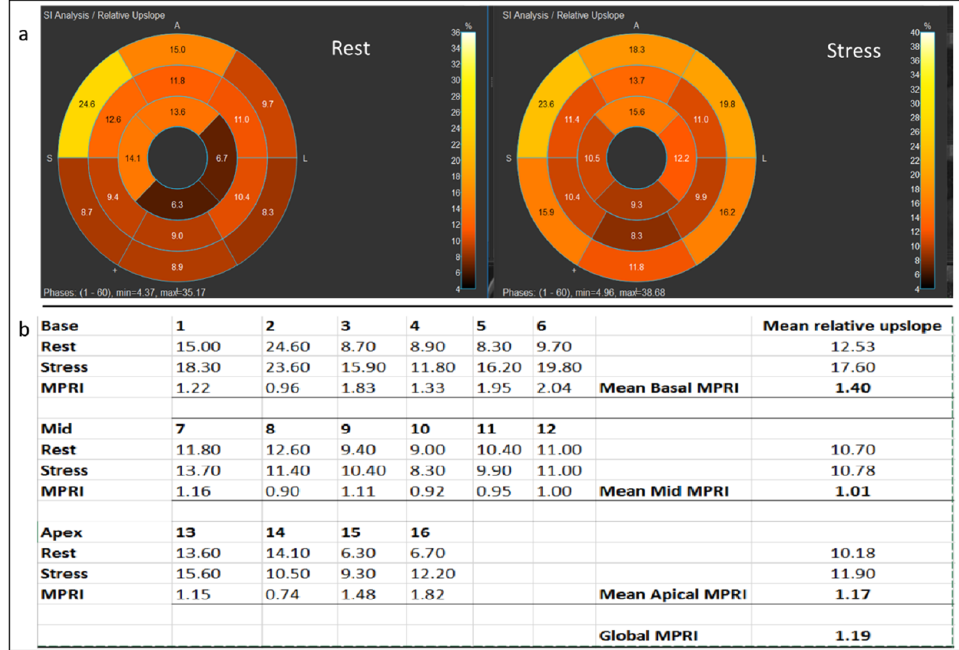
Figure 4. Calculation of global MPRI using relative upslopes at rest and stress. ( a ) shows the AHA 16 segment model depicting the relative upslope at rest and stress in the same 17-year-old male who underwent stress perfusion MRI after coronary unroofing with creation of a neo-ostium for anomalous left coronary artery arising from the right sinus of Valsalva. ( b ) shows how MPRI was calculated for each of the 16 segments as a ratio of the relative upslope at stress to relative upslope at rest. Basal, mid, and apical MPRI was also calculated. Global MPRI is the mean MPRI of all segments.